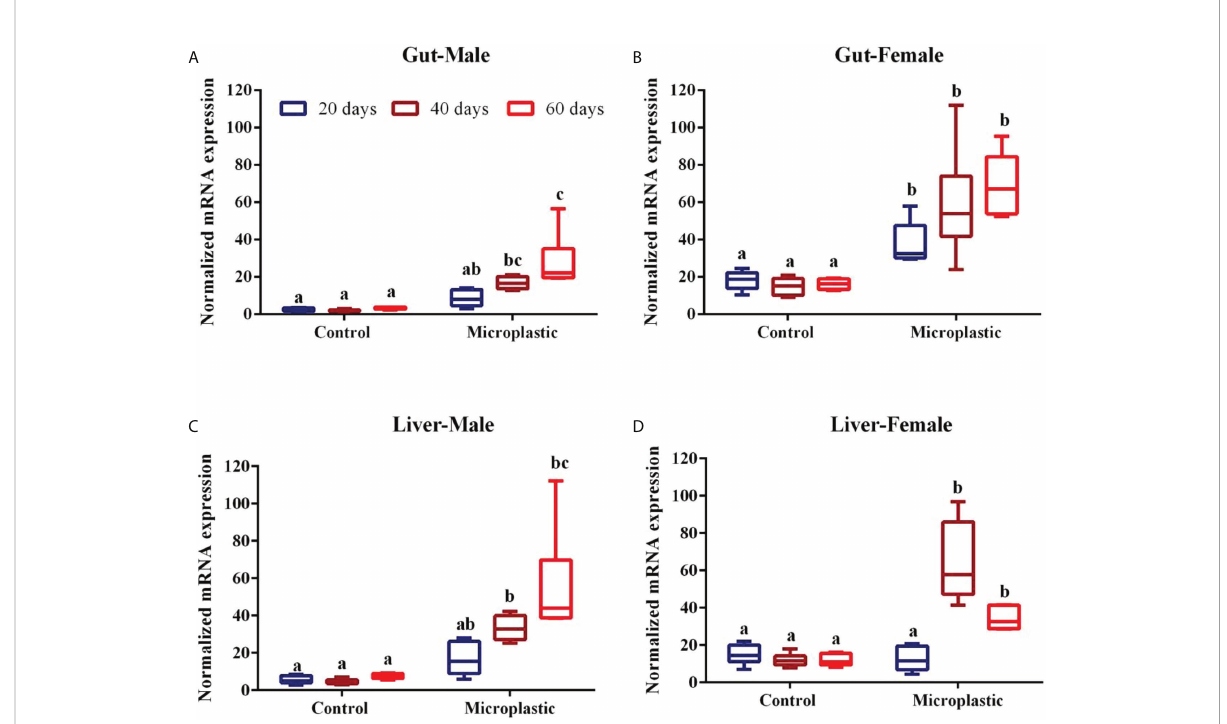
FIGURE 1 Showing the level of glutathione-S-transferase mRNA expression level in fi sh exposed to weathered polyethylene microplastics (A) Gut Male, (B) Gut Female, (C) Liver Male, (D) Liver Female. The line in each box represent median and whiskers represents the upper and lower 95% con fi dence intervals of the mean of six determinations using samples from different preparations. One-way analysis of variance (ANOVA) followed by Tukey ’ s post hoc test was used. The signi fi cant ( P < 0.05) differences between control and exposure groups were indicated by the alphabets; same alphabet shows no signi fi cant difference with respective control group. Different alphabet shows the signi fi cant difference with control respective